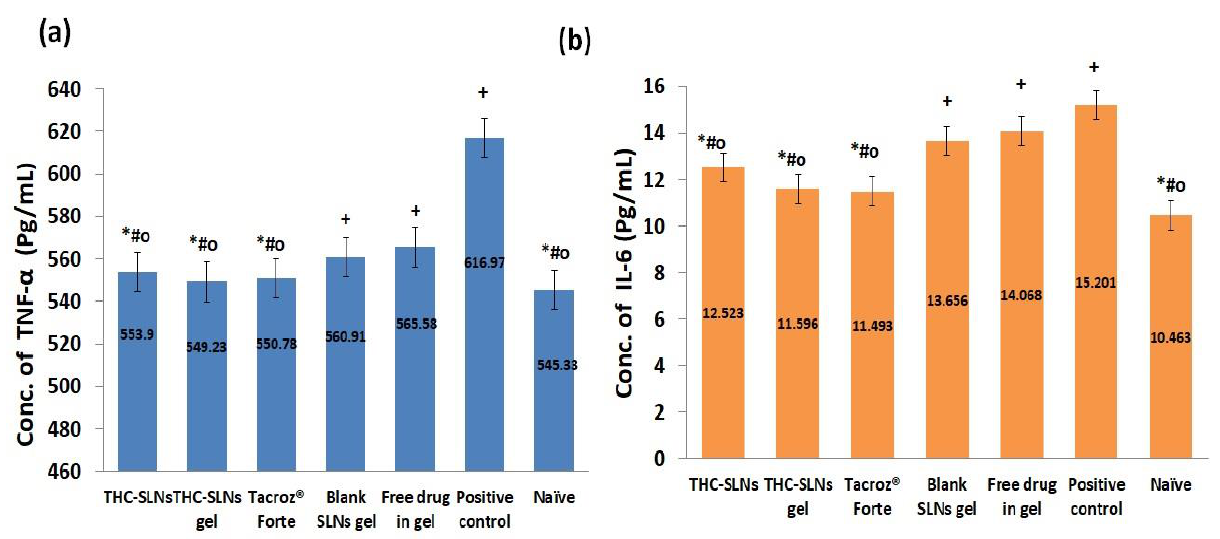
Figure 7. ( a ) Comparative bar graph of concentrations (pg/mL) of TNF- α for the different groups. Values are expressed as mean ± SD (one-way ANOVA followed by Tukey’s test): * denotes insignif- icant difference at p ≤ 0.05 from naïve group; + denotes significant difference as c.f. naïve group; # c.f. positive control at p ≤ 0.05; o c.f. free THC gel group at p ≤ 0.01. ( b ) Comparative bar graph of concentrations (pg/mL) of IL-6 for the different groups. Values are expressed as mean ± SD (one-way ANOVA followed by Tukey’s test): * denotes insignificant difference at p ≤ 0.05 from naïve group; + denotes significant difference as c.f. naïve group; # c.f. positive control; o c.f. free THC gel group at p ≤